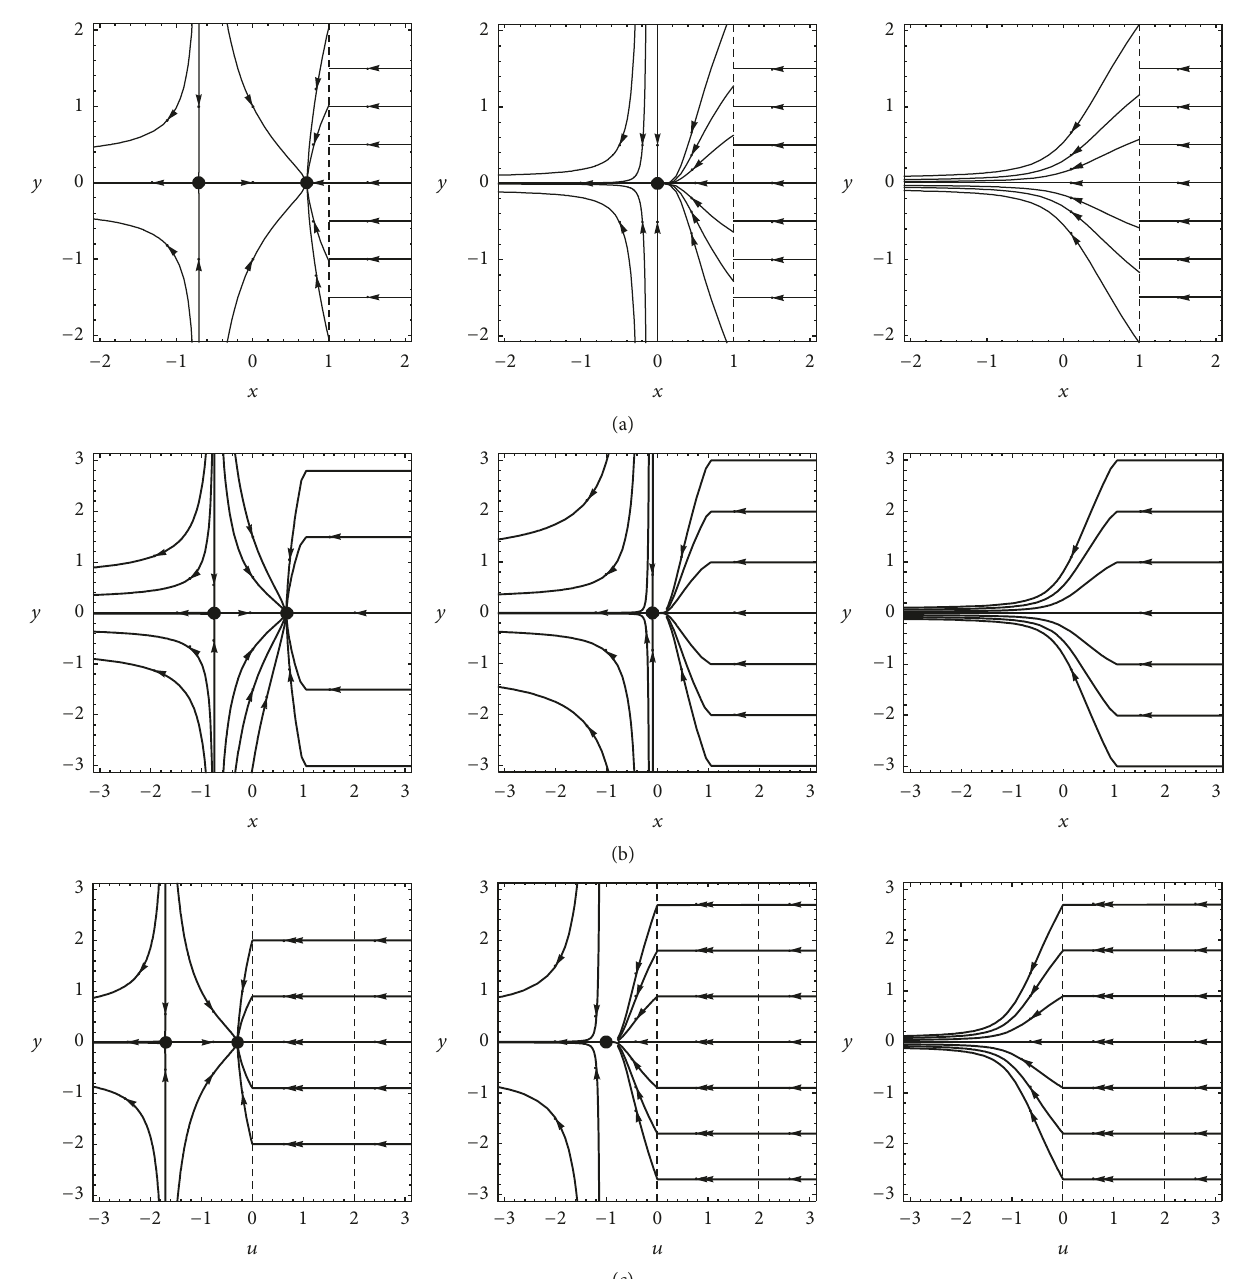
Figure 6: (a) A standard saddle-node bifurcation. (b) The corresponding regularization. (c) The corresponding slow-fast flow.